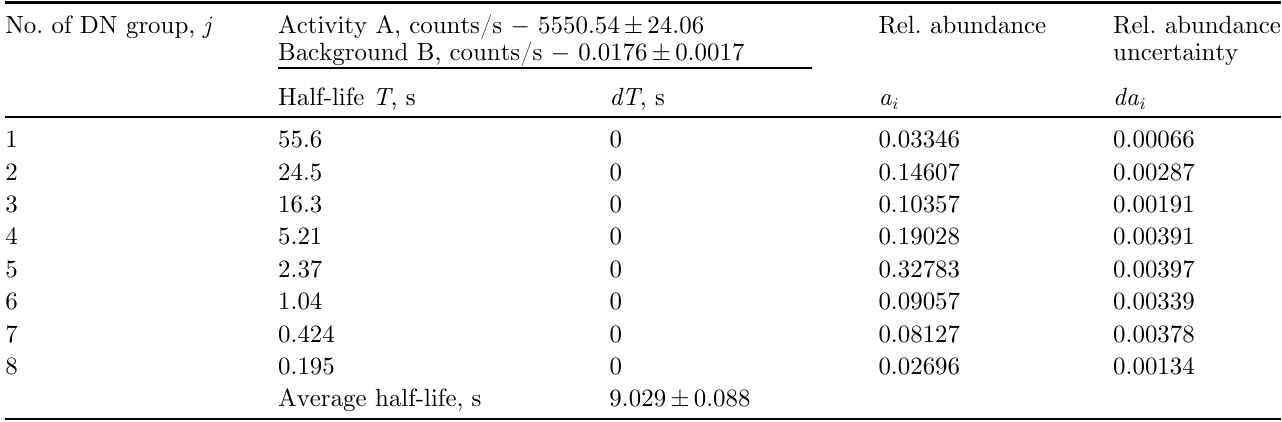
Table 3. The 8-group DN parameters ( a of 235 U by thermal neutrons.